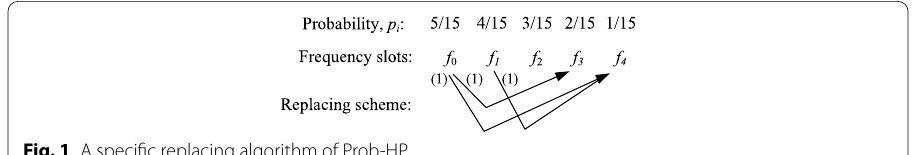
Fig. 1 A specific replacing algorithm of